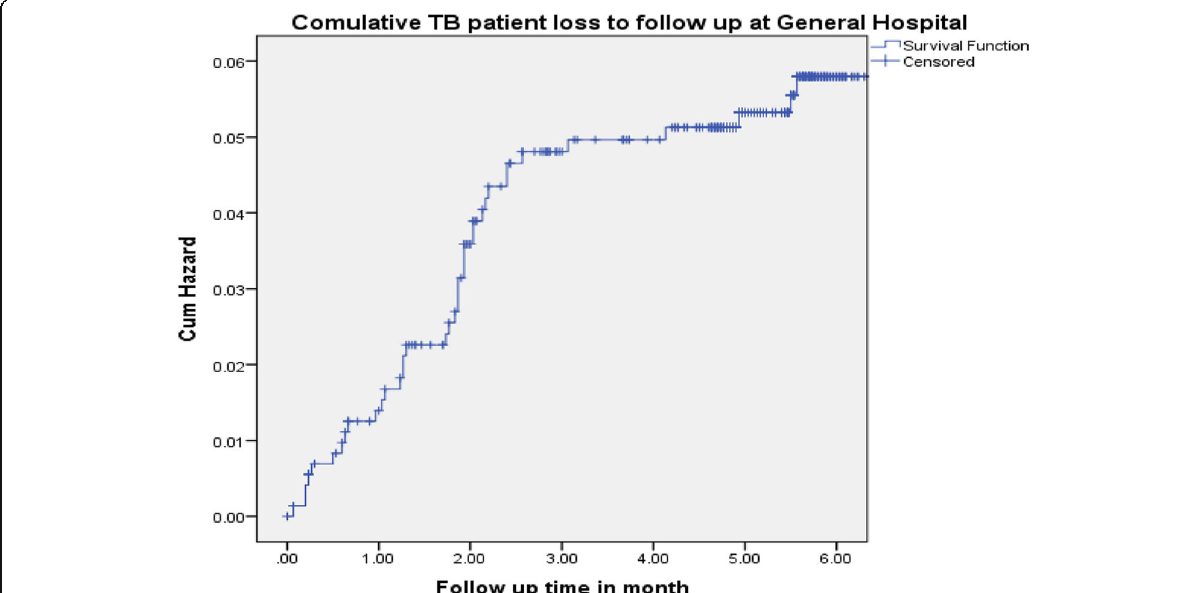
Fig. 2 The TB patient loss to follow-up at the end of intensive and continuation period among tuberculosis patients registered to